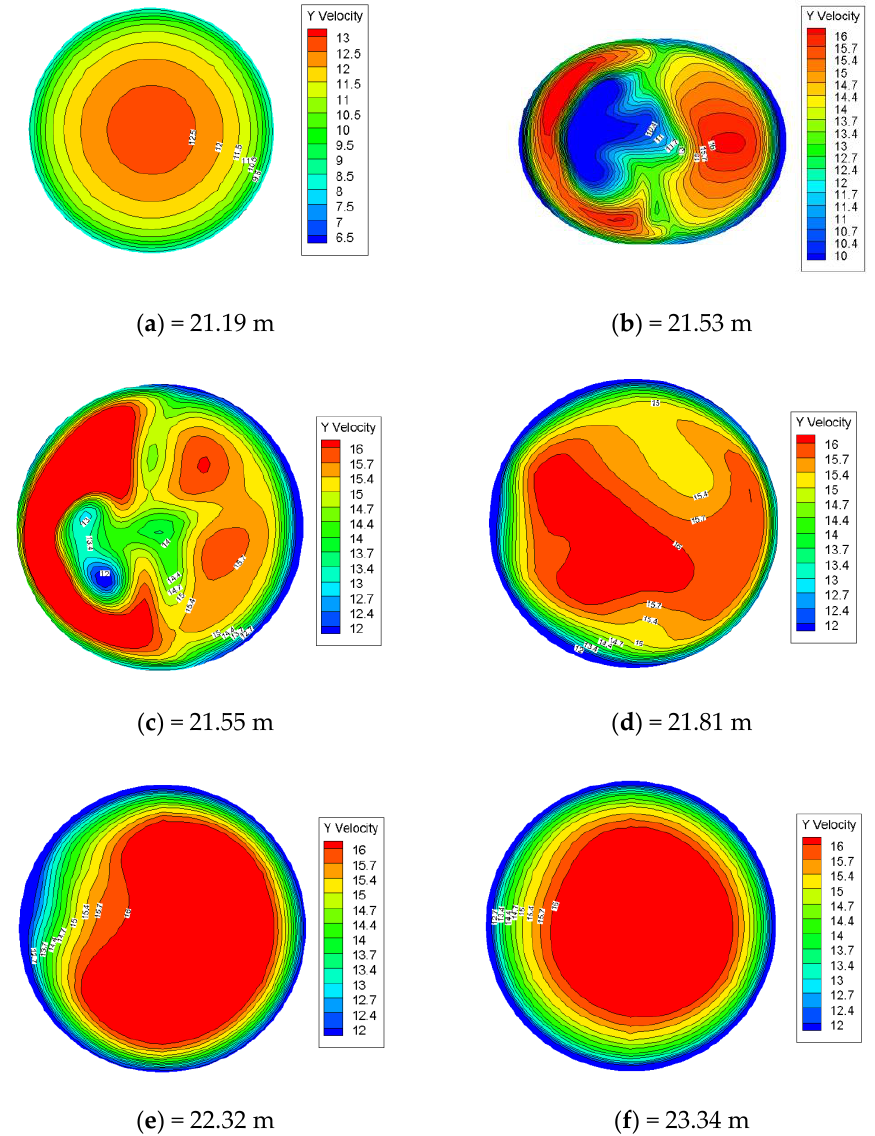
Figure 17. Velocity distribution at different